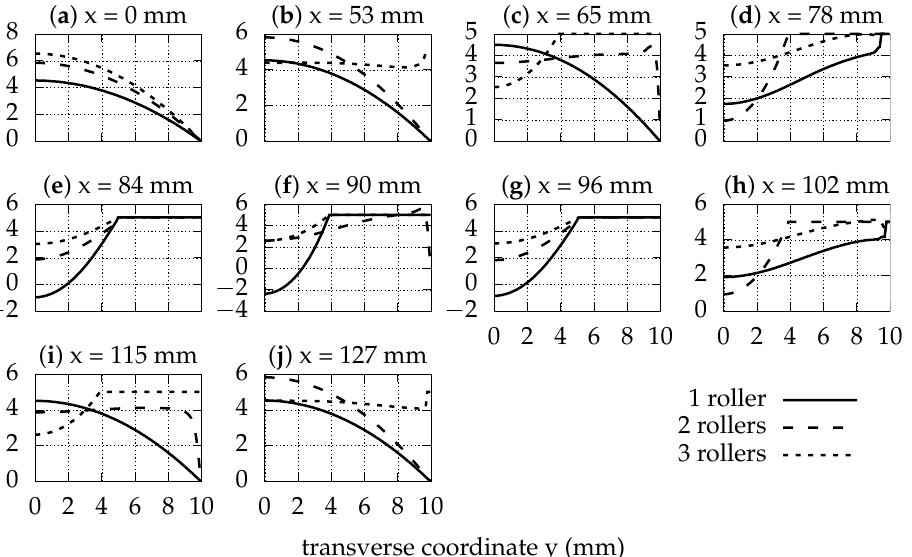
Figure 15. Axial velocity u profiles at successive longitudinal positions x ( a – j ) for various numbers of rollers, c = 5 mm/s, RO = 0.6 and n = 1.